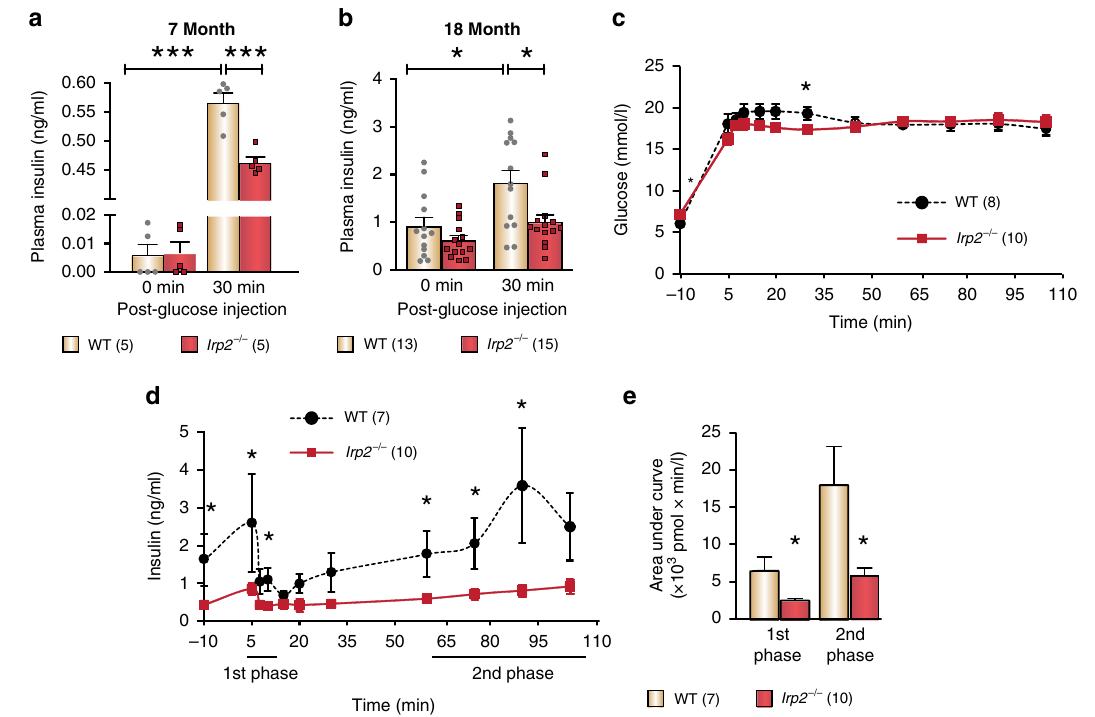
Fig. 2 Glucose-stimulated insulin secretion is blunted in Irp2 − / − mice. a , b Plasma insulin levels in fasted 7-month-old ( a ) and 18-month-old ( b ) WT and Irp2 − / − mice at (0 min) or after glucose injection (30 min). Data are expressed as means ± s.e.m., one-way ANOVA with Tukey ’ s multiple comparison test, * p < 0.05, *** p < 0.001. c – e Hyperglycemic clamp performed in 7-month-old fasted WT and Irp2 − / − mice. Glucose ( c ) and insulin ( d ) levels measured at the indicated times. e Insulin AUC corresponding to the fi rst phase (0 – 15 min) and second phase (60 – 105 min) of insulin secretion are shown. Data in c – e are expressed as means ± s.e.m., unpaired two-tailed Student ’ s t test, * p < 0.05 relative to WT mice. The number of mice is indicated in parentheses. Source data are provided as a Source Data fi the expression of ferritin and TfR1, the levels of Fth1- and Ftl1- subunits, and TfR1 were assessed in WT and Irp2 − / − islets.